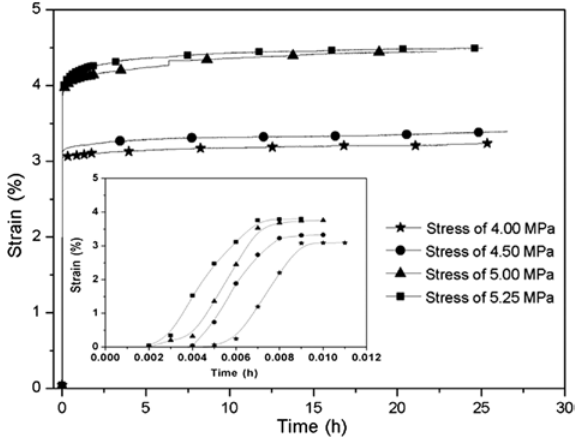
Figure 3: The “apparent” creep curve at less than 5.50 MPa.